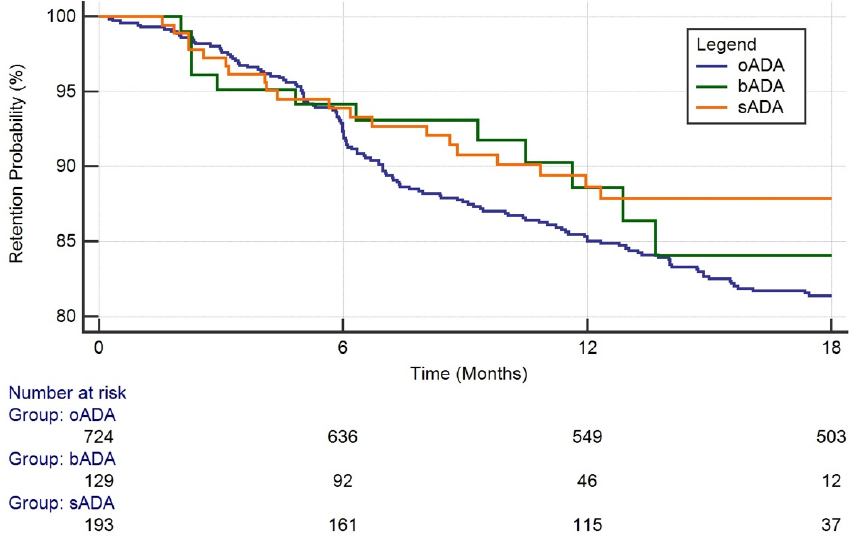
Figure 1. 18 ‐ month retention rate according to oADA, bADA and sADA. oADA = naive to ADA when receiving the originator; bADA = naive to ADA when receiving ABP 501; sADA = switcher from originator to ABP